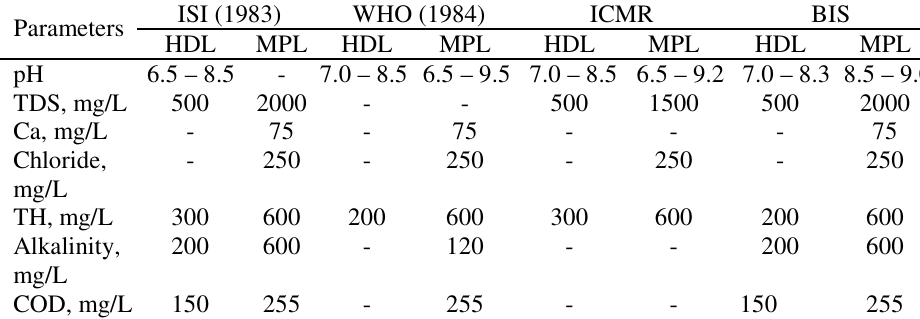
Table 1. Drinking water quality